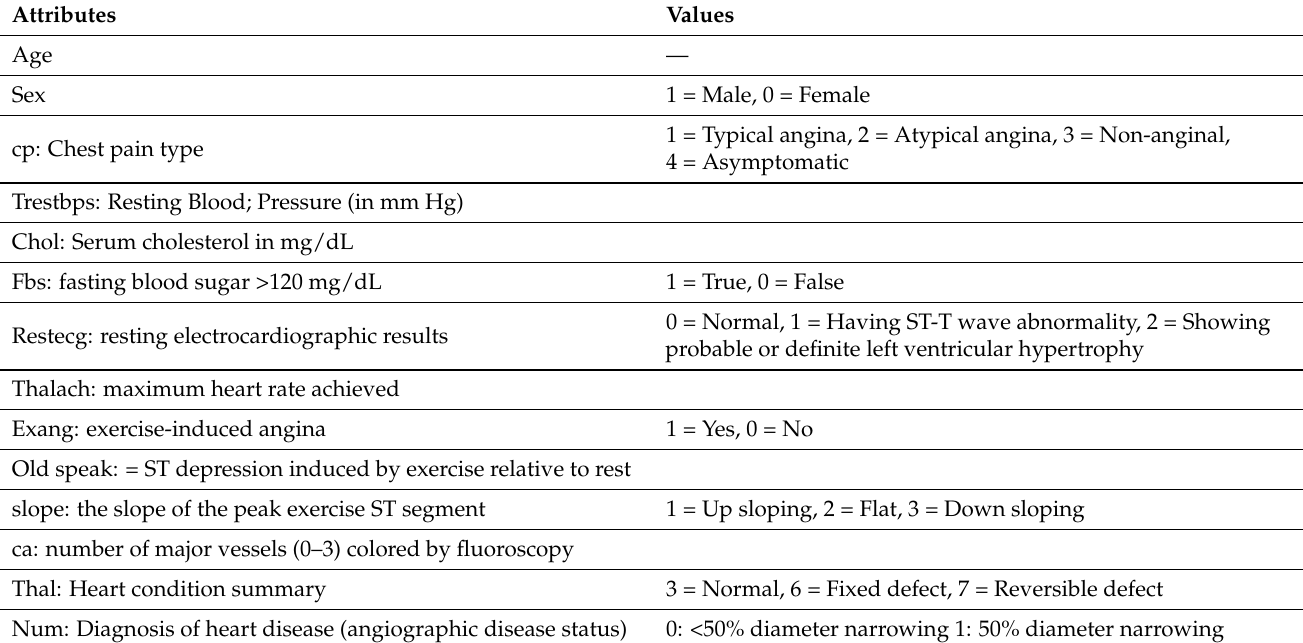
Table 2. Heart disease dataset based on